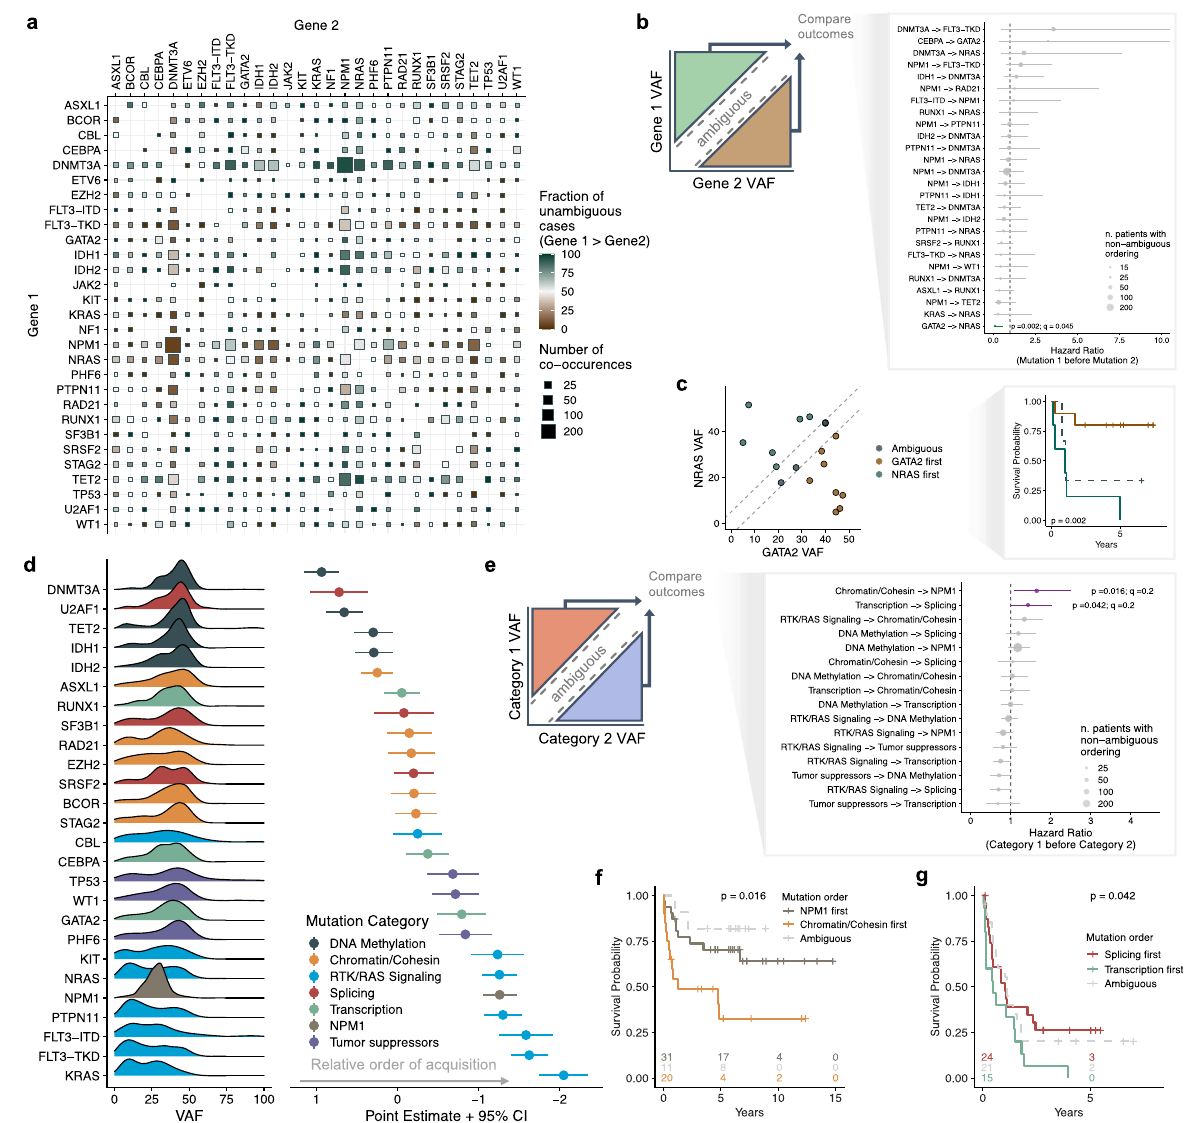
Fig. 4 Clonal dominance of co-occurring mutations strati fi es survival. a Summary of pairwise clonal relationships for recurrent mutations present in de novo AML. Color represents the fraction of patients where mutations in gene 1 occurred before gene 2 (i.e. are clonally dominant; green = gene 1 before gene 2; brown = gene 1 after gene 2). Size is scaled to re fl ect the total number of patients with co-occurring mutations. b Schematic depicting how pairwise VAF relationships were used to bin patients into groups (left) and forest plot of hazard ratios calculated from univariate Cox proportional-hazards modeling based on the order of pairwise mutations (right). Points represent the hazard ratio, as calculated using standard Cox proportional-hazards regression, between patients with different mutation order. Bars represent the 95% con fi dence intervals of the hazard ratios and points are sized based on the number of patients with de fi ned mutation ordering. c Scatterplot (left) and Kaplan – Meier plot (right) showing how the order of mutation acquisition in patients with co-occurring mutations in NRAS and GATA2 robustly improved patient strati fi cation. Green points/line represent cases where NRAS mutations occur before those in GATA2 . Brown points/line represent cases where GATA2 mutations occur before those in NRAS . The reported p -value was calculated using a two-sided log-rank test. d A Bradley – Terry model was used to assign the relative order of global mutation acquisition from pairwise relationships as determined in a . Only patients with at least two mutations were considered in this model. Density plots (left) represent the VAF distribution for each mutation in the analysis (corrected for copy number and X-linkage in males) and are ordered on the y -axis based on their relative order of acquisition compared to all other genes in the analysis. Points and error bars (right) represent the Bradley – Terry model results for the point estimate and 95% con fi dence interval, respectively, for relative gene ordering in temporal acquisition. e Schematic depicting how pairwise VAF relationships were used to bin patients into groups (left) and forest plot of hazard ratios calculated from univariate Cox proportional-hazards regression modeling based on the order of mutation category acquisition (right). Bars represent the 95% con fi dence intervals of the hazard ratios. f , g Kaplan – Meier plots for signi fi cant pairs from e . p -values in c , f , g were calculated between nonambiguous groups using a two-sided log-rank test. Source data are provided as a Source Data fi